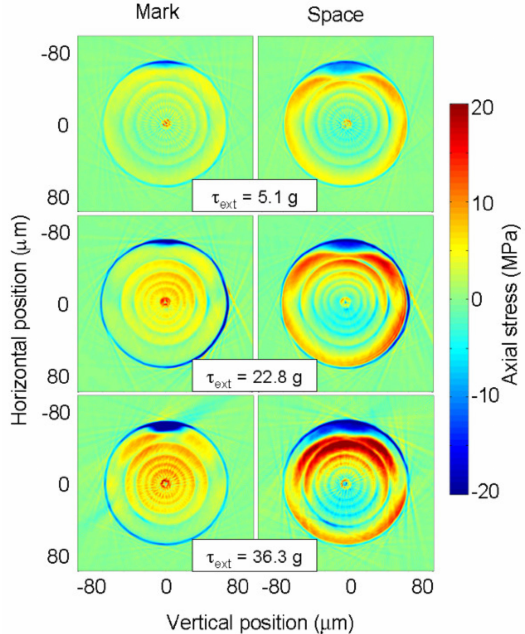
Figure 9. Tomographic stress profiles of the fiber drawn with the highest tension where LPFGs were induced using different pulling tensions. Reprinted with permission from ref. [118]. © 2005 IEEE.